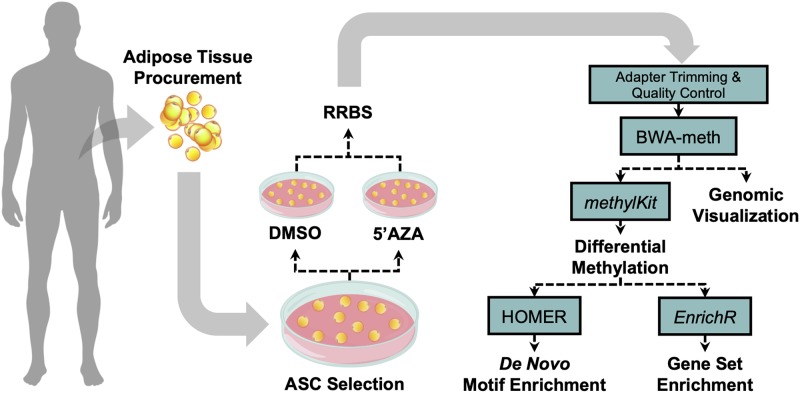
Visual illustration of sample processing and data analysis pipeline. Abdominal white adipose tissue was biopsied from two patients, and subsequently plated for adipose-derived mesenchymal cell selection and treatment with 5′-AZA or vehicle (DMSO) for 24 h. Isolated DNA was bisulfite-reduced and sequenced, followed by bioinformatic analysis of differential CpG methylation.